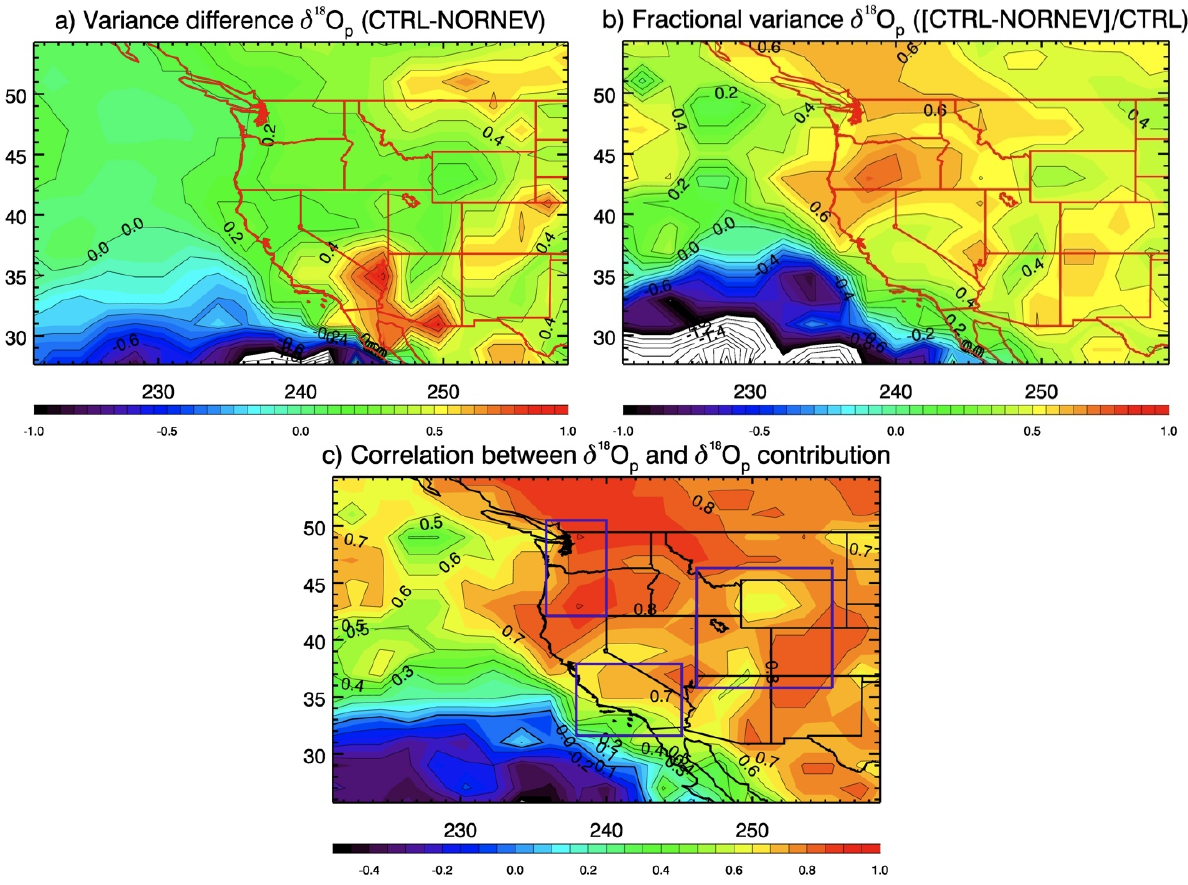
Figure 2. ( a ) Variance difference between the control simulation (CTRL) simulation and the simulation that removed isotope effects from post-condensation exchanges (NORNEV); ( b ) The same variance difference divided by the variance of the CTRL simulation; ( c ) Correlation between interannual δ 18 O variations from the CTRL simulation and the p between the CTRL simulation and NORNEV simulation. Open purple difference in δ 18 O p rectangles in panel (c) show the boxed regions for Figure 3.